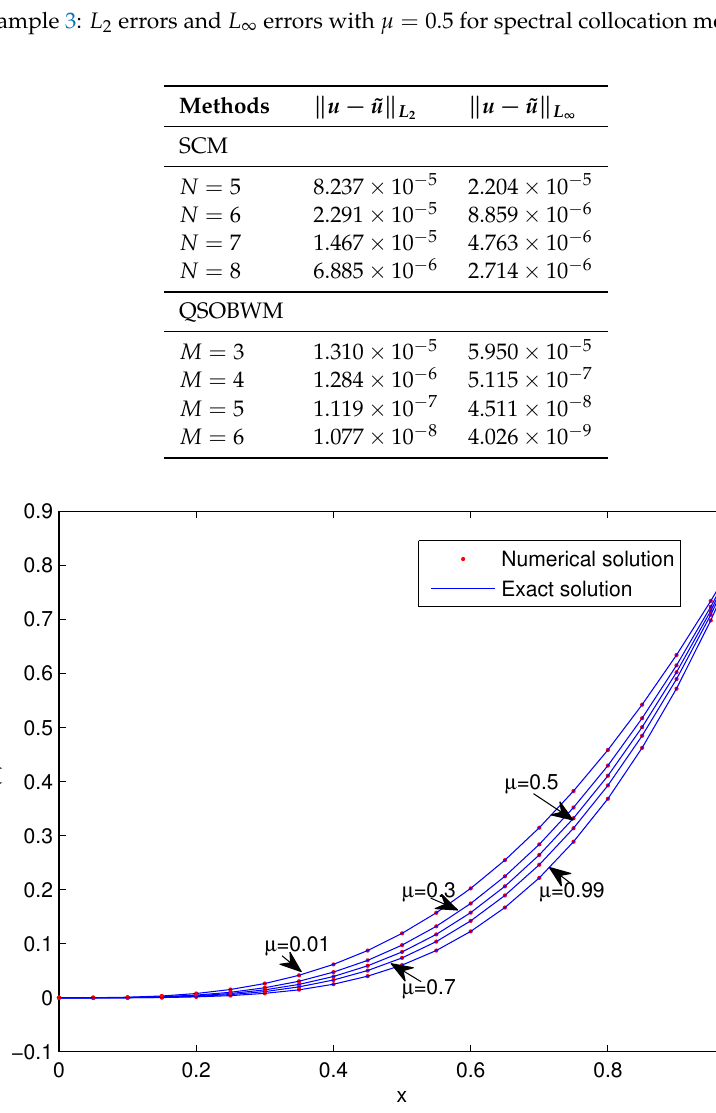
Figure 4. Analytical and approximate results of QSOBWM for M = 3 with µ = 0.01,0.3,0.5,0.7, and 0.99 for Example